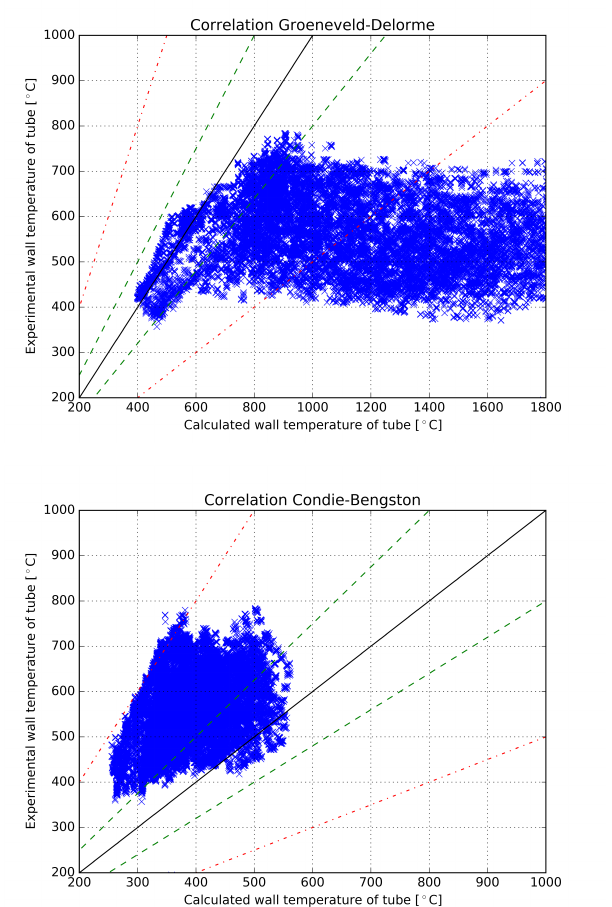
Figure 2. Comparison of experimental and calcu- lated values of wall temperature with use of DFFB